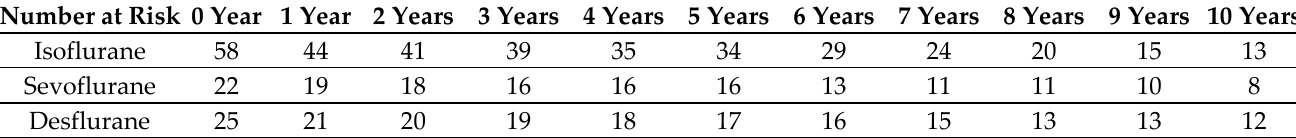
Figure 1. Pancreas graft survival according to the primary inhaled anesthetic agent used at SPKT. With regard to cox regression analysis, it could be shown that donor and recipient age, recipient BMI, and the duration of pancreas CIT are independent prognostic